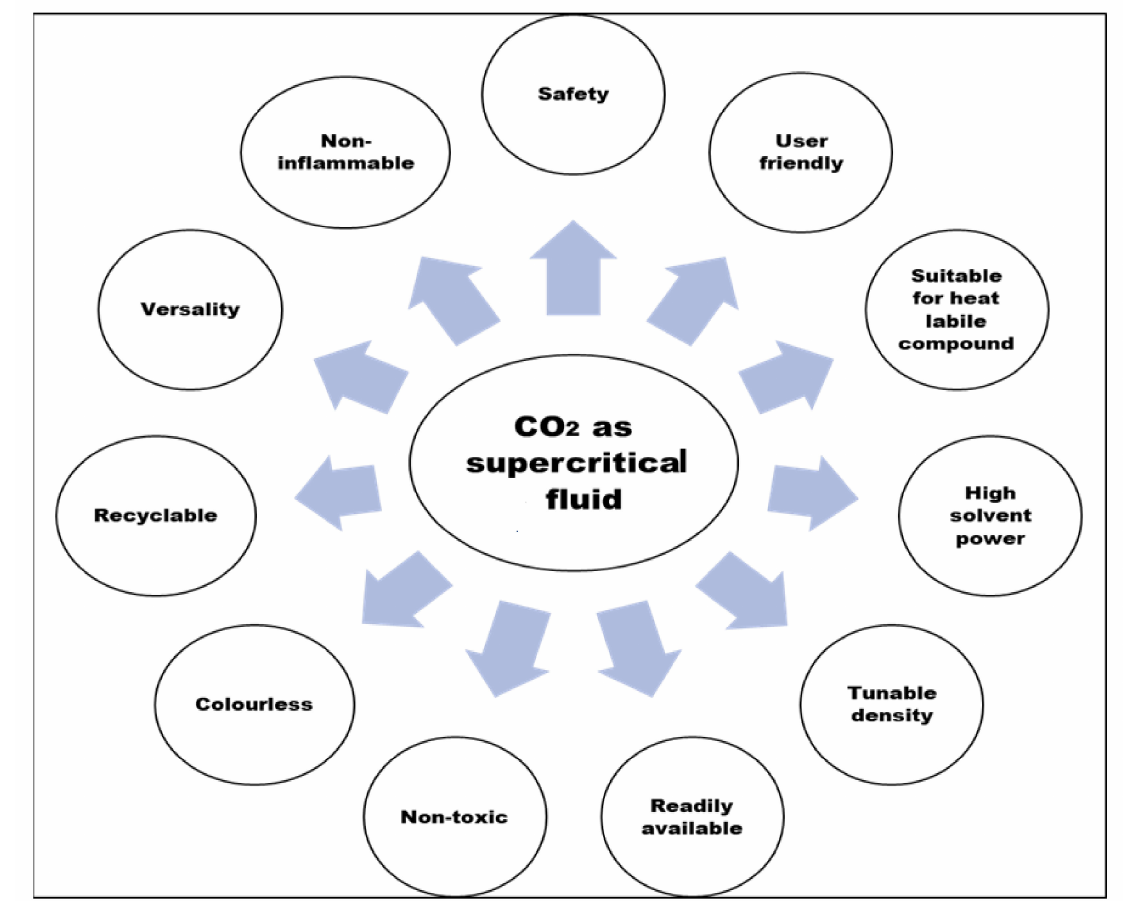
Figure 4. Suitability of CO 2 in supercritical fluid